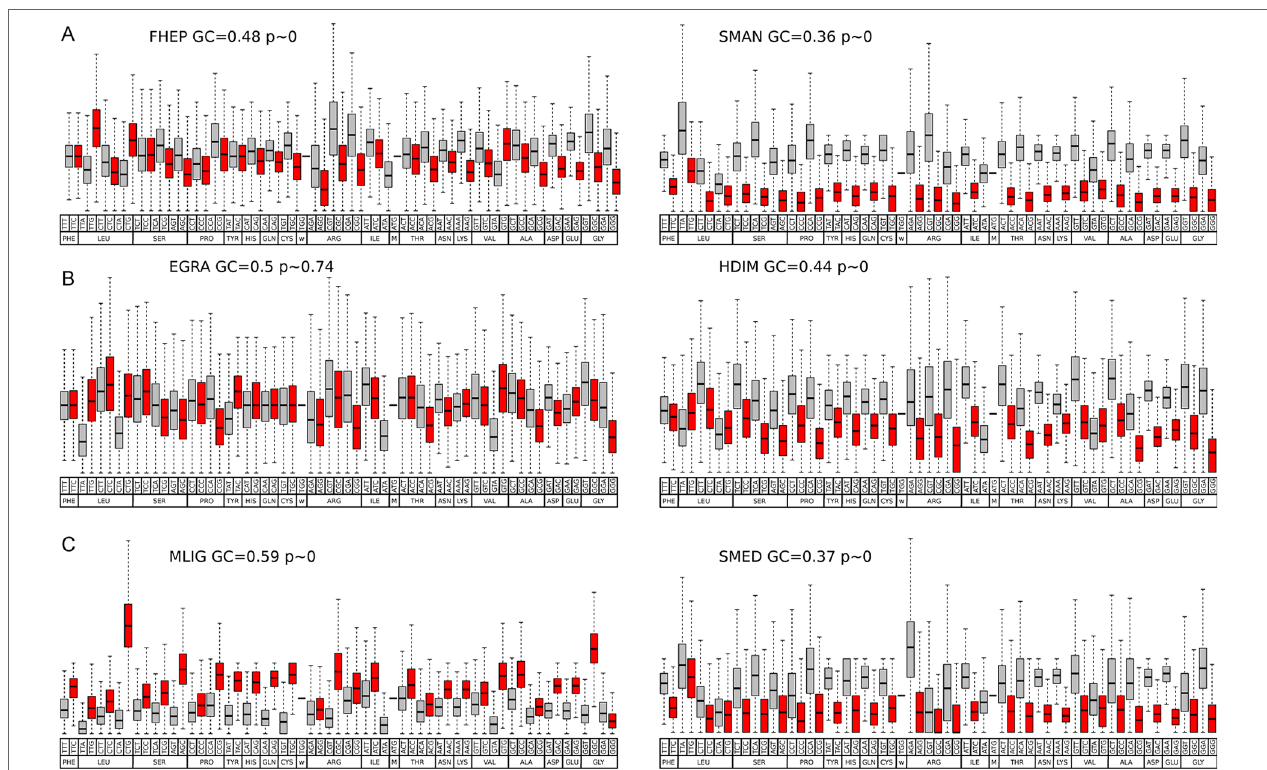
FIGURE 4 | Codon usage in representative species of flatworms. Boxplot of codon usage in six representative species of the diverse lineages and GC content across flatworms. (A) comparison of the trematodes F. hepatica and S. mansoni ; (B) comparison of the cestodes E. granulosus and H. diminuta ; (C) comparison of the free-living M. lignano and S. mediterranea . GC- and AT-ended codons are grey and red coded for ease of visualization. Mean GC values and p values are indicated.